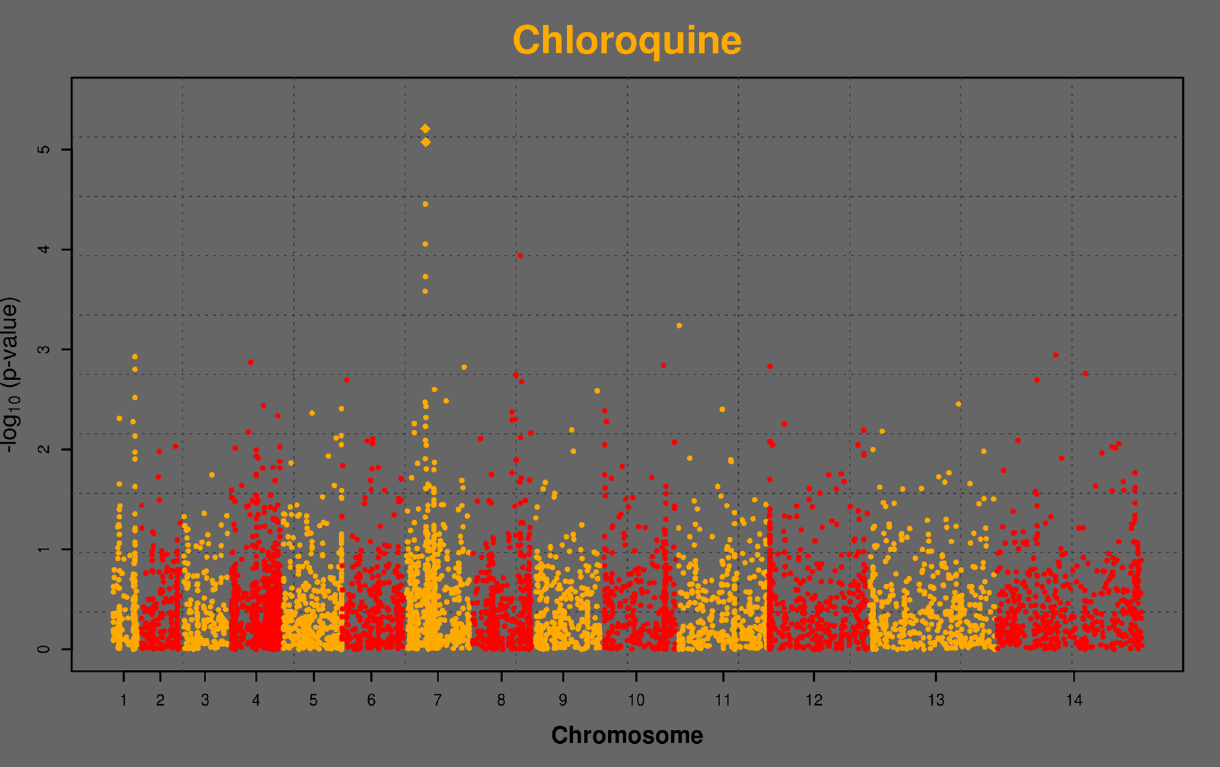
Figure 1. Manhattan plot of genome-wide associations with CQ activities from 35 parasite isolates. Horizontal axis is genome position, and vertical axis is –log 10 (p-value). Chromosomes alternate yellow and red, starting from chromosome 1 on the left. Yellow spire on chromosome 7 is in the region of pfcrt .